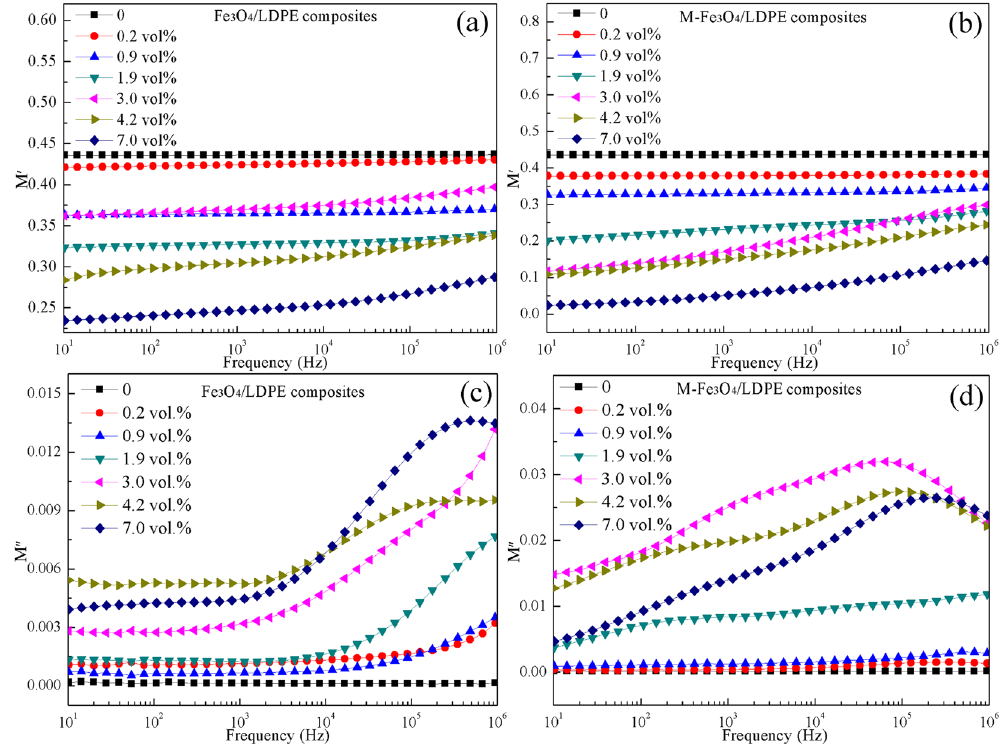
Figure 6. Frequency dependence of the ( a , b ) real parts and ( c , d ) imaginary parts of the complex electric modulus for the